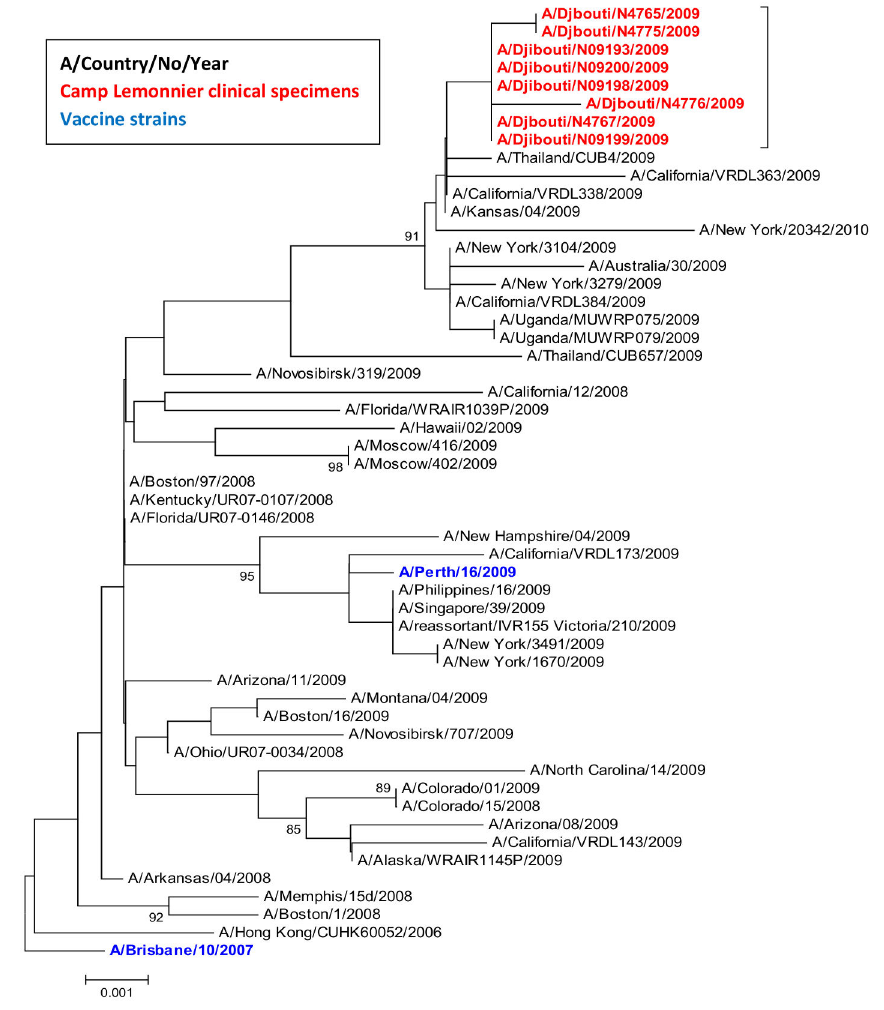
Figure 3. Phylogenetic analysis of H3N2 NA gene segments. *Phylogenetic tree of influenza A/H3N2 using the Neighbor- Joining method and Bootstrap test (1000 replicates). The evolutionary distances were computed using the Maximum Composite Likelihood method. The phylogenetic tree was generated using MEGA4 software. Phylogenetic analysis rooted to the 2009 influenza vaccine strain